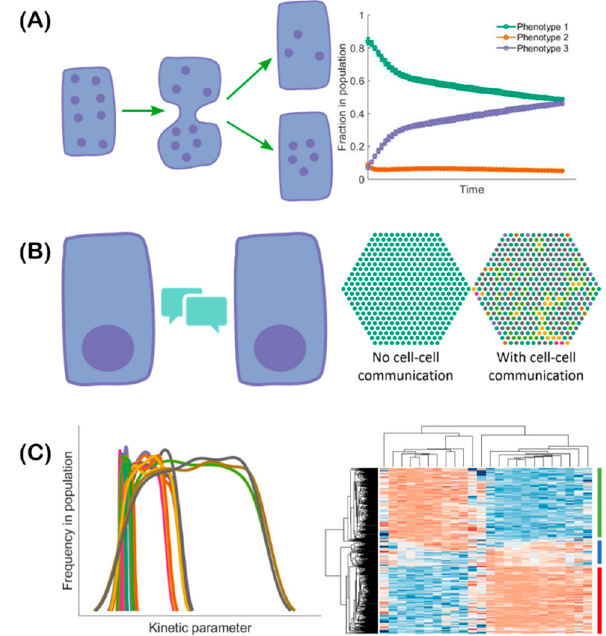
Figure 2. Multiple mechanisms can lead to EMT-associated population heterogeneity. ( A ) During cell division, noise can lead to asymmetric partitioning of molecules among daughter cells. This may lead to the daughter cell exhibiting a phenotype different from that of the parent cell. Consequently, the fractions of cells exhibiting different phenotypes can change over time. ( B ) Cell–cell communication